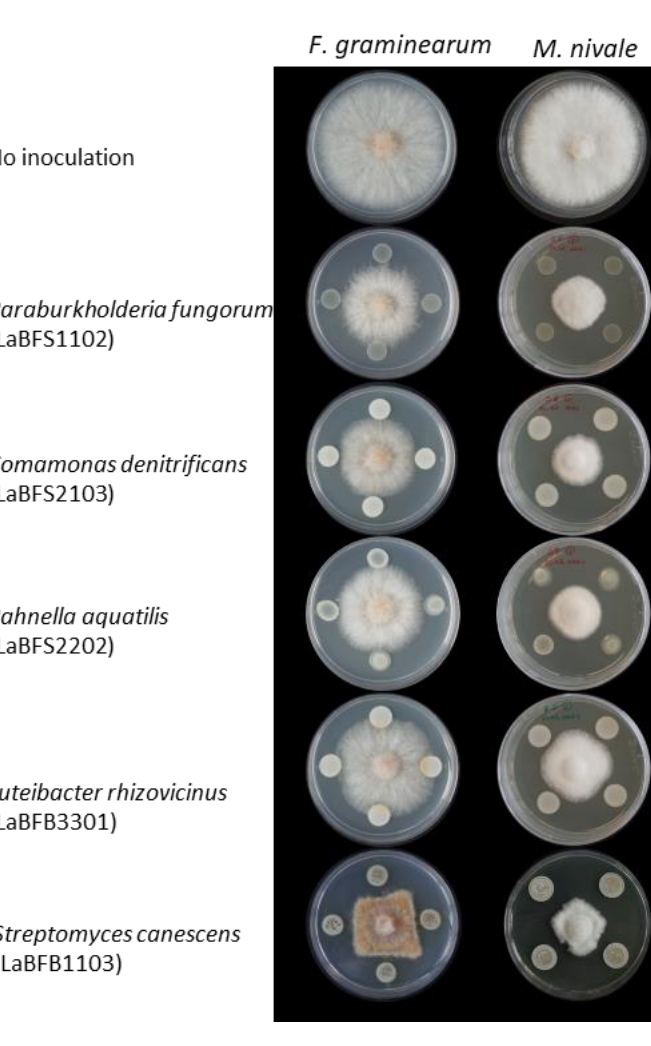
Figure 6. Dual-culture test of representative strains. The antagonistic activities of the isolates against F. graminearum varied from 0% to 49.6% and differed between the bacterial group from shoot and root (Tukey–Kramer method, p = 0.00817) (Figure